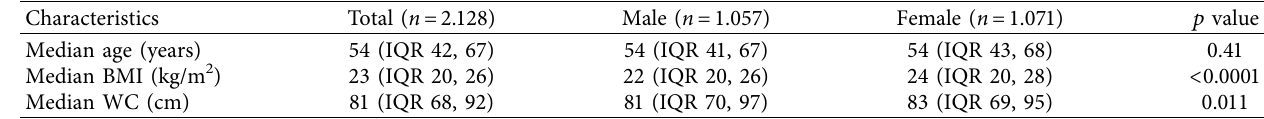
Table 1: Baseline characteristics.